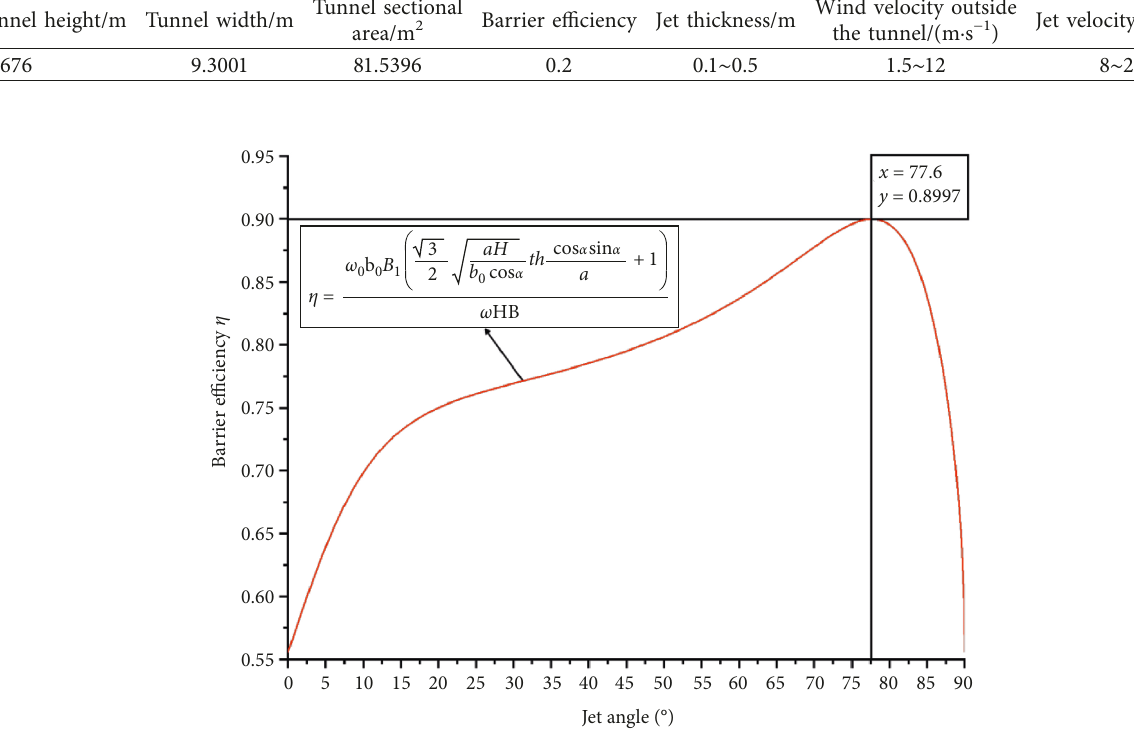
Figure 6: The relationship between the air curtain jet angle and barrier efficiency. Table 2: The relationship between jet velocity and wind velocity outside the tunnel, barrier efficiency. External wind speed